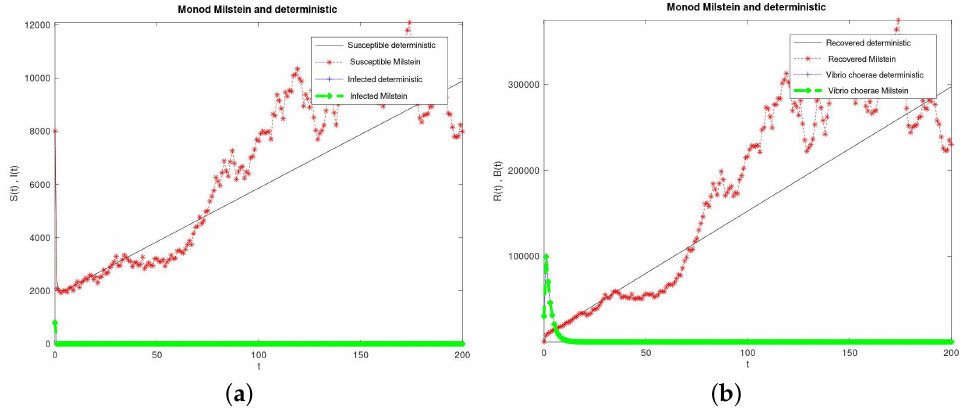
Figure 9. Simulation showing the dynamic behavior of ( a ) susceptible humans, ( b ) infected humans, recovered humans, and the Vibrio cholerae population, and is given for A = 1500; β 1 = 0.2143; β 2 = 0.000002; d = 0.015; δ = 0.33; ζ = 100; α = 0.025; µ = 0.0000548; r = 0.004; σ = 0.05; K = 10 9 ; u 1 = 0.9; u 2 = 0.91; u 3 = 0.94; e 1 = 0.05; e 2 = 0.05; e 3 = 0.05; and e 4 = 0.05. We increased the recruitment rate of the susceptible population from 15 per day to 1 500 per day. Figure 9a, revealed that the susceptible population increases and then dropped slightly and the infected remained lowered and at steady state over time while the stochastic simulation is very close to the simulation results of the deterministic model but the fluctuation in the susceptible population became much stronger. Figure 9b, also revealed that the recovered population increases over time while the population of the vibrio cholerae decreases over time and their stochastic simulation are very close to the simulation results of the deterministic